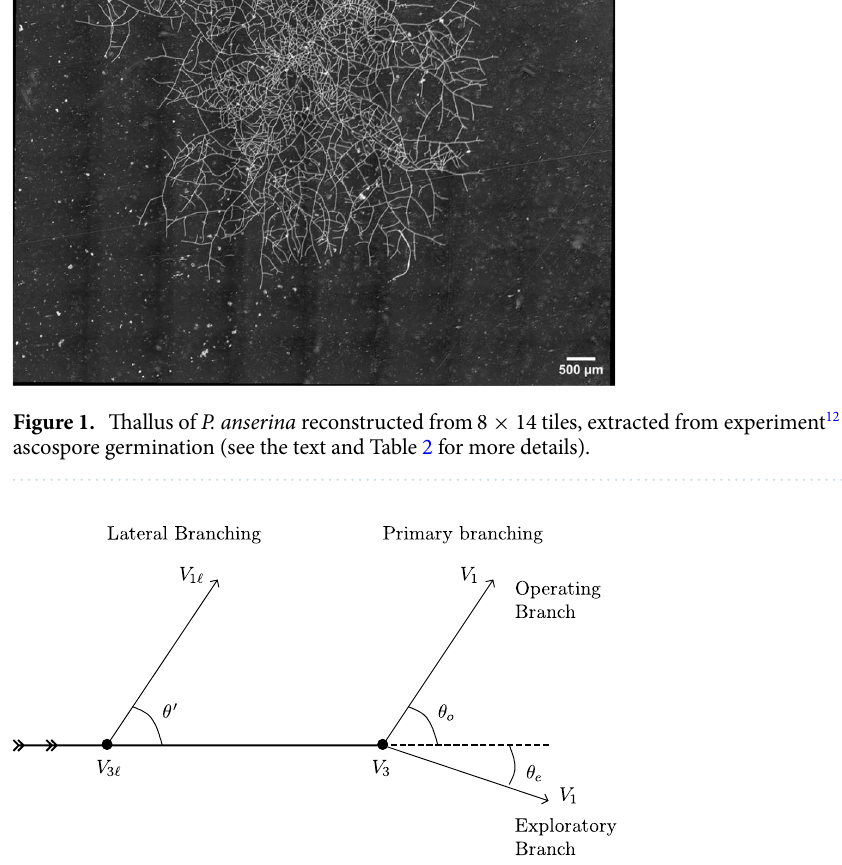
Figure 2. Definitions used in this work. The thick line is the mother hypha, while the thin lines are the daughter hyphae. We consider two types of three degrees vertices. V 3 ℓ are lateral branchings, connected with the angle θ ′ . V 3 are apical branchings on which two branches are connected: an operating and an exploratory branch with respective angles θ o and θ e . V 1 (resp. V 1 ℓ ) are one degree vertices (i.e. apexes) coming from V 3 (resp. V 3 ℓ